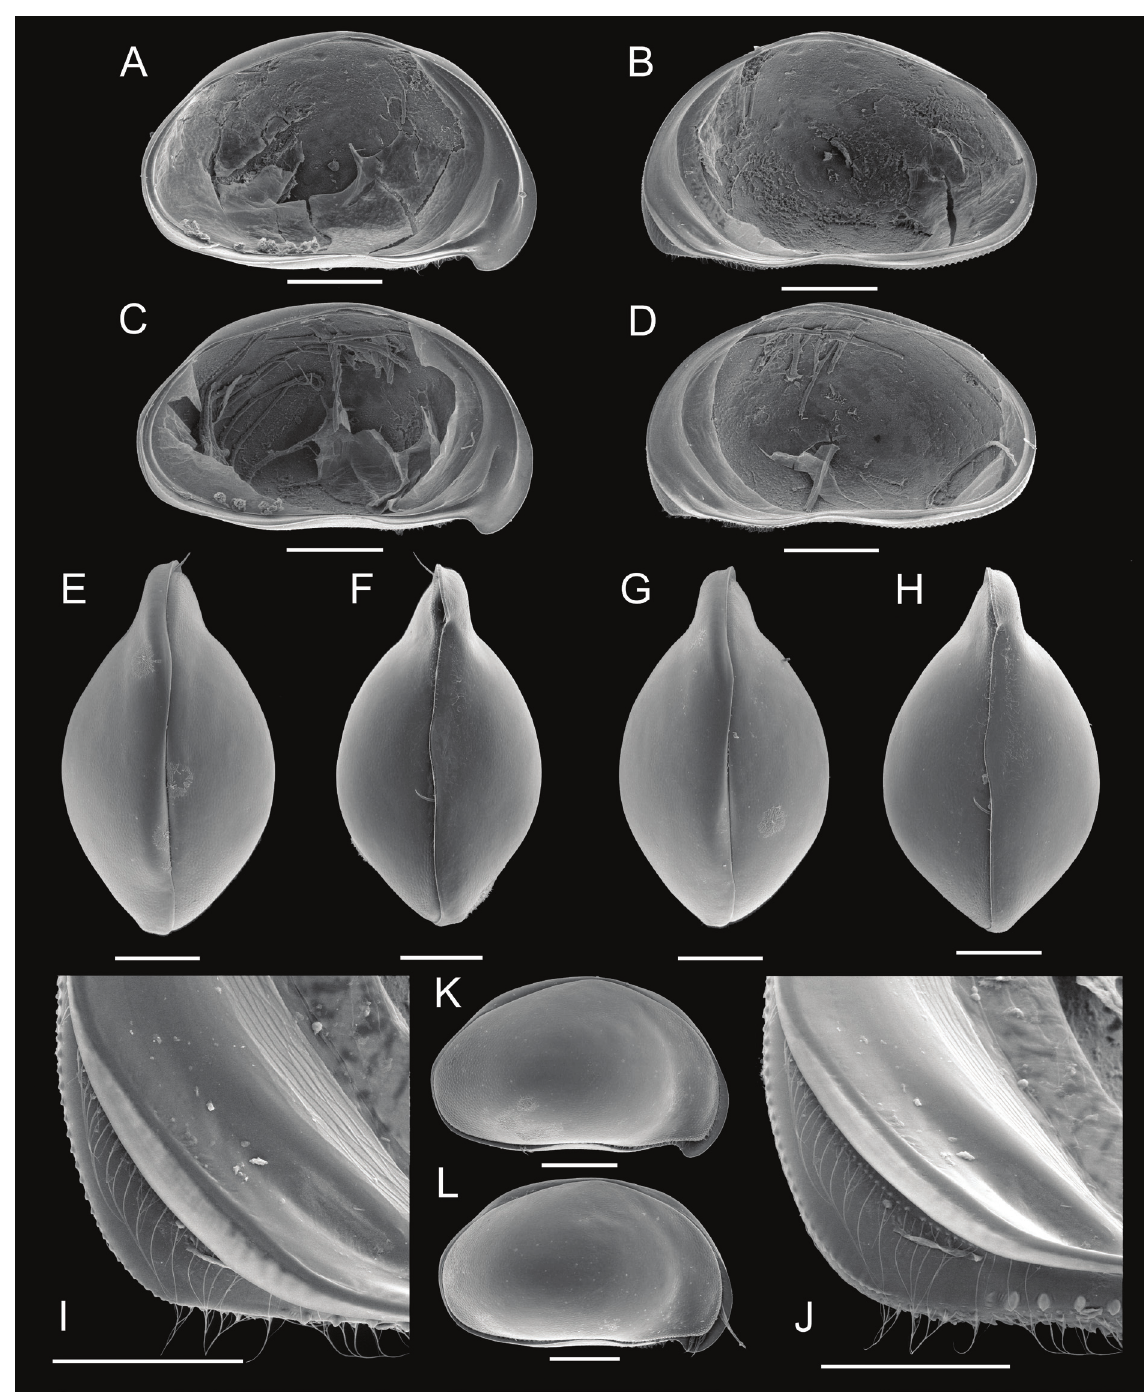
Fig. 23. Bennelongia kimberleyensis sp. nov. (all from Taylors Lagoon, Kimberley, type locality). A . LVi (allotype ♀, WAM.C49433). B . RVi (♀, Idem). C . LVi (♂, WAM.C49437). D . RVi (♂, Idem). E . Cp dorsal (♀, WAM.C49435A). F . Cp ventral (♀, WAM.C49435C). G . Cp ventral (♂, WAM. C49436A). H . Cp dorsal (♂, WAM.C49436B). I . RVi (detail anteriorly, allotype ♀, WAM.C49433). J . RVi (detail anteriorly, ♀, Idem). K . CpRe (♀, WAM.C49435B). L . CpRe (♂, WAM.C49436C). Scales: A-H, K-L = 500 µm; I-J = 200